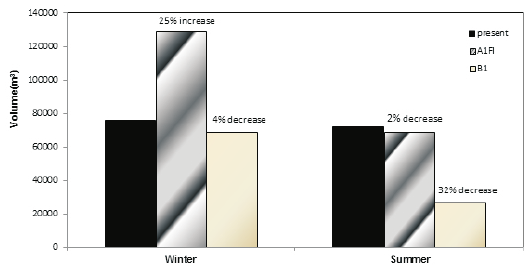
Figure 3: Number of Properties at risk of flooding due to surcharged sewers in the present and future 2080s under scenario AFI (high) & B1 (low) for winter and summer. N.B. The percentage shown in the bar chart indicates a decrease and/or increase in design storm of the drainage system in the future compared with the baseline design